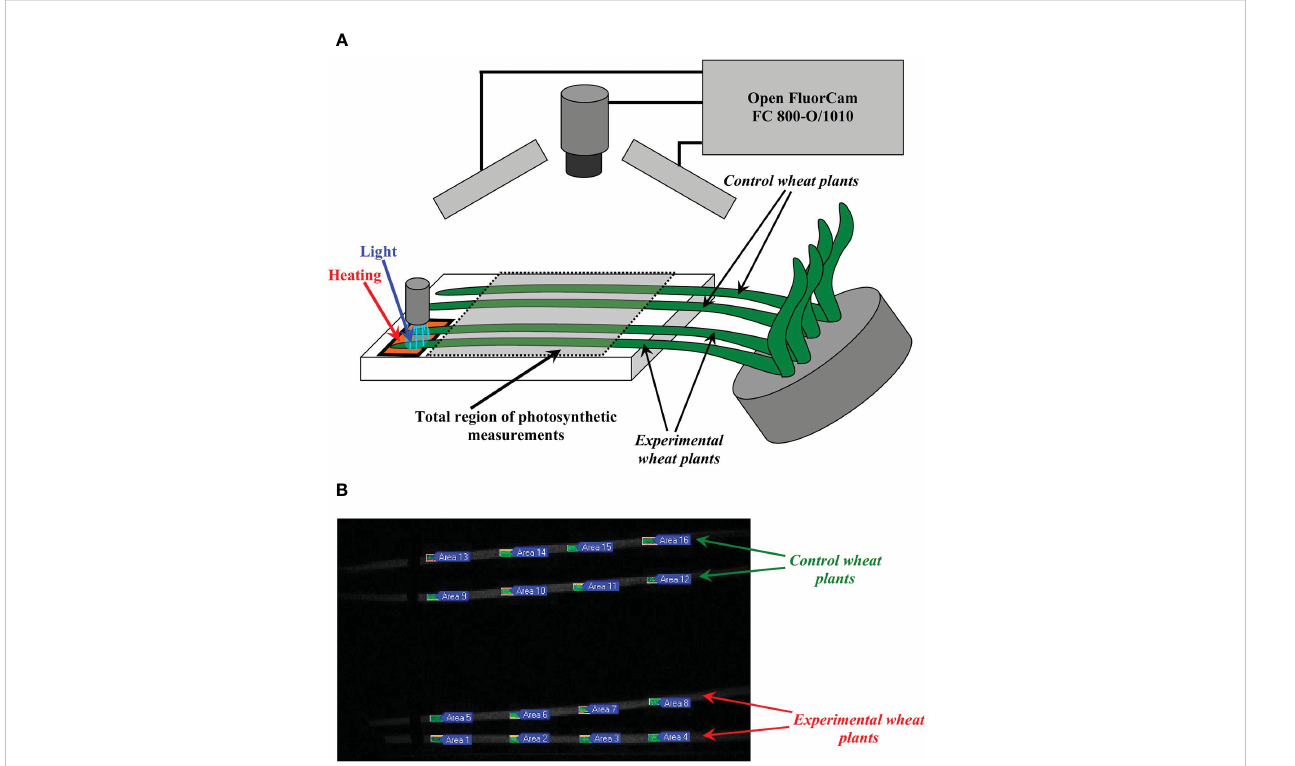
FIGURE 1 Scheme of experimental set providing to local action of heating and blue light on top of wheat plants and to photosynthetic measurements (A) , and example of localizations of ROIs in experimental and control wheat plants (B) . Local action of heating (40°C) and blue light (540 µmol m -2 s -1 ) were described in detail in our previous work (Yudina et al., 2023); duration of illumination equaled to 10 min after initiation of irritation, and duration of heating equaled to about 45 min. PAM imaging Open FluorCam FC 800-O/1010 was used for measurements of quantum yield of photosystem II ( Ф PSII ) and non-photochemical quenching of chlorophylls (NPQ). Photosynthetic measurements were initiated in 15 min before the irritation after 15- min dark adaptation and subsequent 30-min adaptation under standard white actinic light of this system (86, 456, or 838 µmol m -2 s -1 ). Four wheat plants (two plants with irritations and two control plants) were simultaneously measured in each experiment. In each plant, Ф PSII and NPQ were investigated in four ROIs with centers in 3, 5, 7, and 9 cm from the border of the irritated